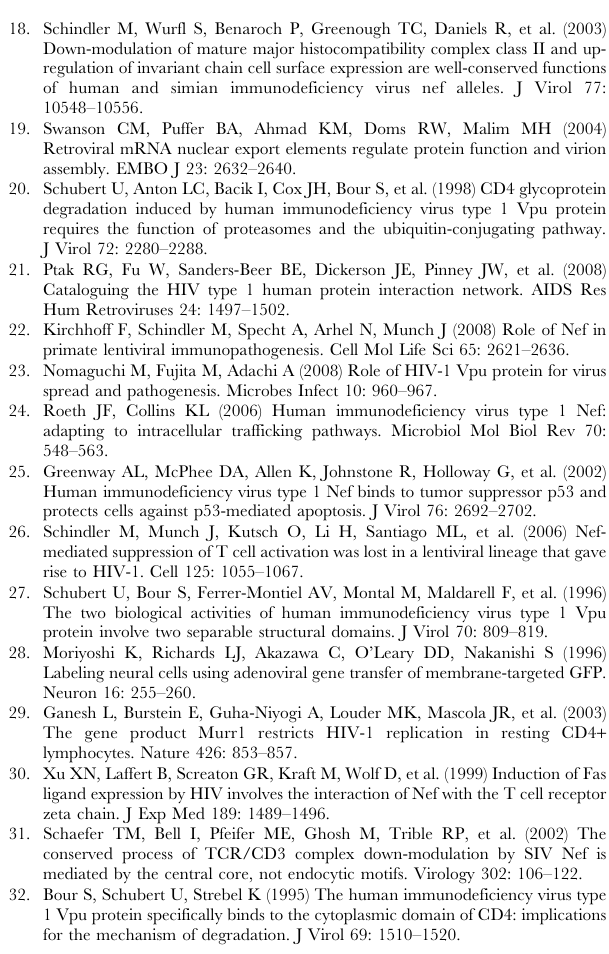
using BsrGI and NotI together with the linkers indicated. Figure S2 Analyses of cell surface receptor modulation by Nef and Vpu fusion proteins. Jurkat cells were electroporated with pEYFP-only, pEYFP-MEM, pEYFP HIV-1 NA7 Nef, pEYFP- SIV mac239 Nef or pEYFP-NL4-3 Vpu and down-modulation of CD4, CD3 and MHC-I by the different viral proteins was measured by flow cytometry as described in the methods section. Receptor cell surface expression of pEYFP-only electroporated cells was set as 100%. Presented are means and standard deviations of two independent experiments. Found at: doi:10.1371/journal.pone.0009344.s002 (0.23 MB TIF) Figure S3 Colocalization and subcellular localization of viral and cellular fusion-proteins. Confocal images of 293T cells that were cotransfected with the indicated YFP- and CFP-fusion proteins. The top panel shows three different cells that were transfected with the indicated YFP-fusion proteins only. The left panel shows individual cells that were transfected with the indicated CFP-fusion proteins only. YFP is shown in green and CFP is shown in red. Figure S4 Untagged NL4-3 Vpu protein immunoprecipitates CD317. 293T cells were transfected with the pCG-NL4-3 Vpu and a FLAG-tagged CD317. Vpu complexes from cellular lysates